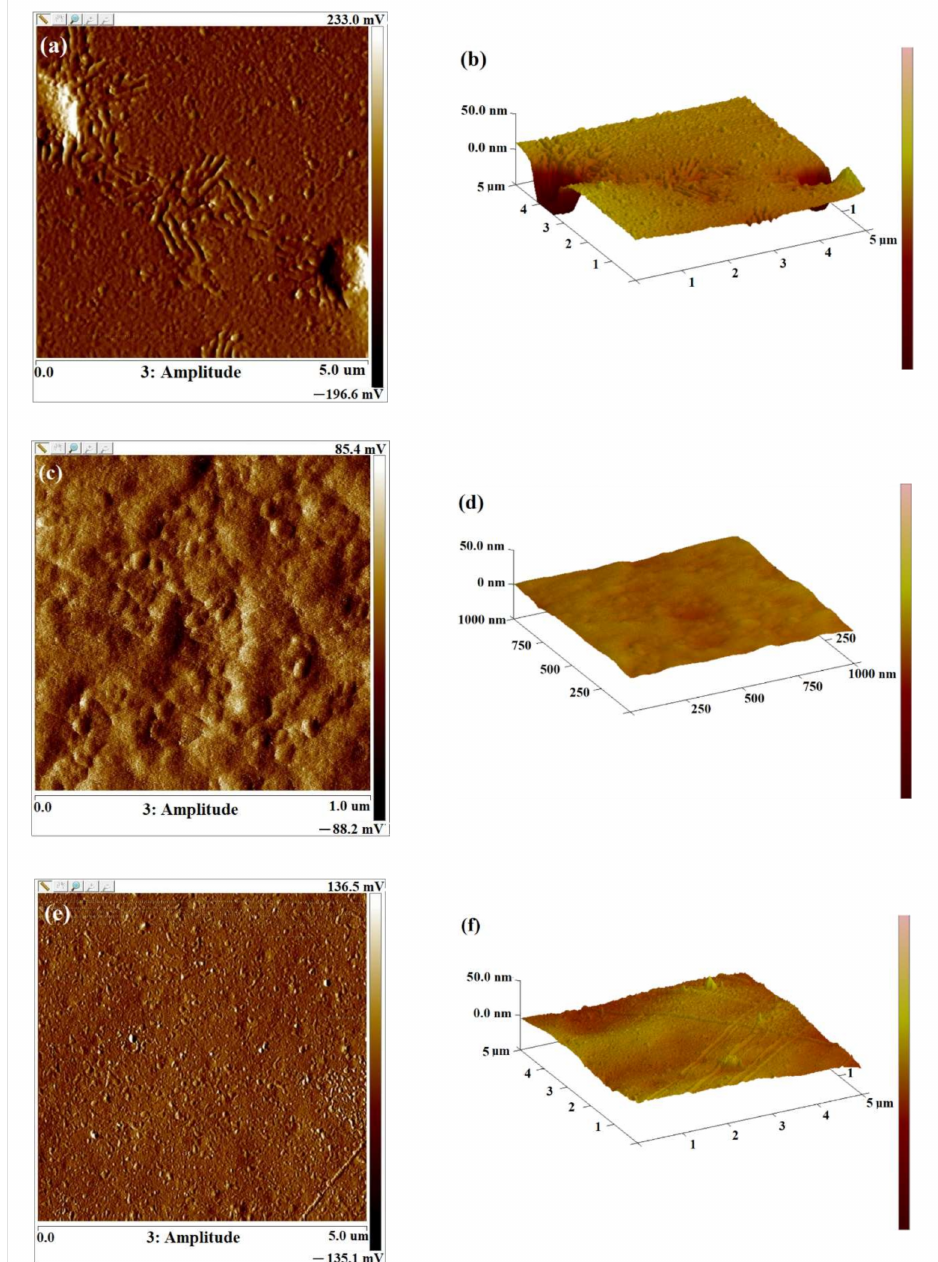
Figure 5. AFM images of the surface of levan films before irradiation ( a , b ) and after 44 h of irradiation with a polychromatic lamp ( c , d ) and an LED lamp ( e , f